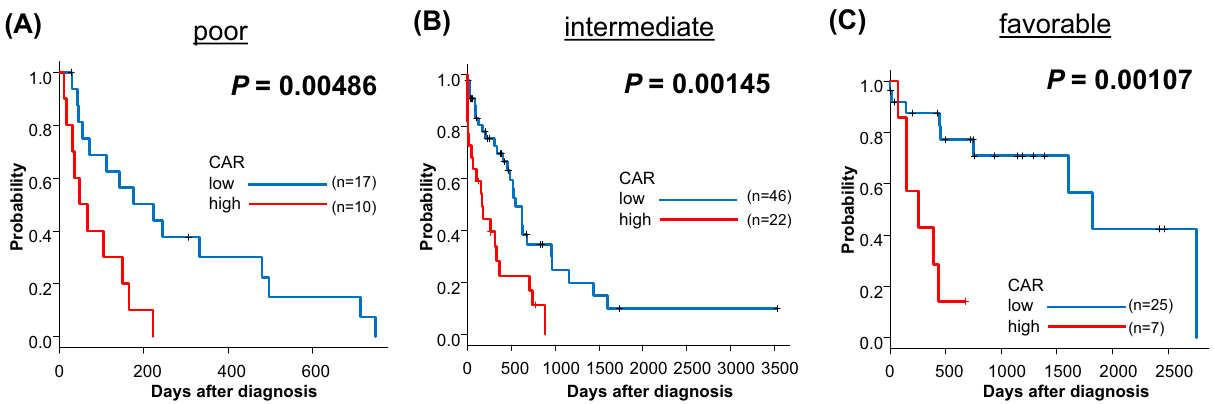
Figure 5. Kaplan–Meier plots of OS according to CAR in patients without 3 complications (active infection/ active malignant tumor/collagen disease) at diagnosis, and categorized with poor risk ( A ), intermediate risk ( B ), and favorable risk ( C ) stratified by NCCN 2017 risk classification.